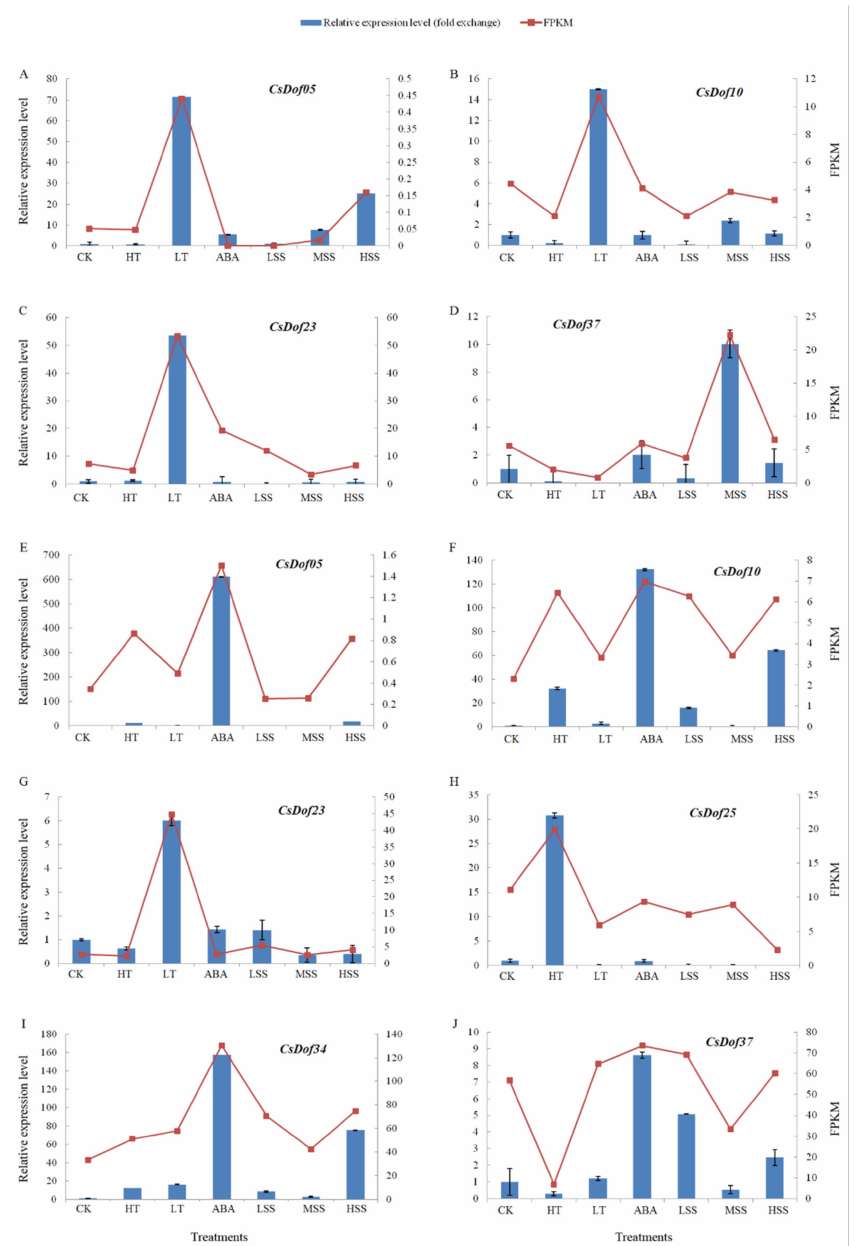
Figure 7. The expression profiles of CsDof genes in leaf and root in C. songorica under high/low temperature, ABA, and salt stresses. The expression profiles of CsDof05 , CsDof10 , CsDof23 , and CsDof37 in leaf are shown in ( A – D ), respectively. The expression profiles of CsDof05 , CsDof10 , CsDof23 , CsDof25 , CsDof34 , and CsDof37 in root are shown in ( E – J ), respectively. The x-axis indicates treatments. Left y-axis indicates relative expression level. Right y-axis means genes abundance change based on FPKM values according to RNA-Seq. Error bars indicate standard deviations of independent biological replicates ( n = 3). CK: denotes 0 h, HT: high temperature (40 ◦ C), LT: low temperature, ABA: ABA (100 µ M), LSS: 50 mM NaCl (light salt stress), MSS: 100 mM NaCl (moderate salt stress), and HSS: 200 mM NaCl (high salt stress), respectively, administered for 24